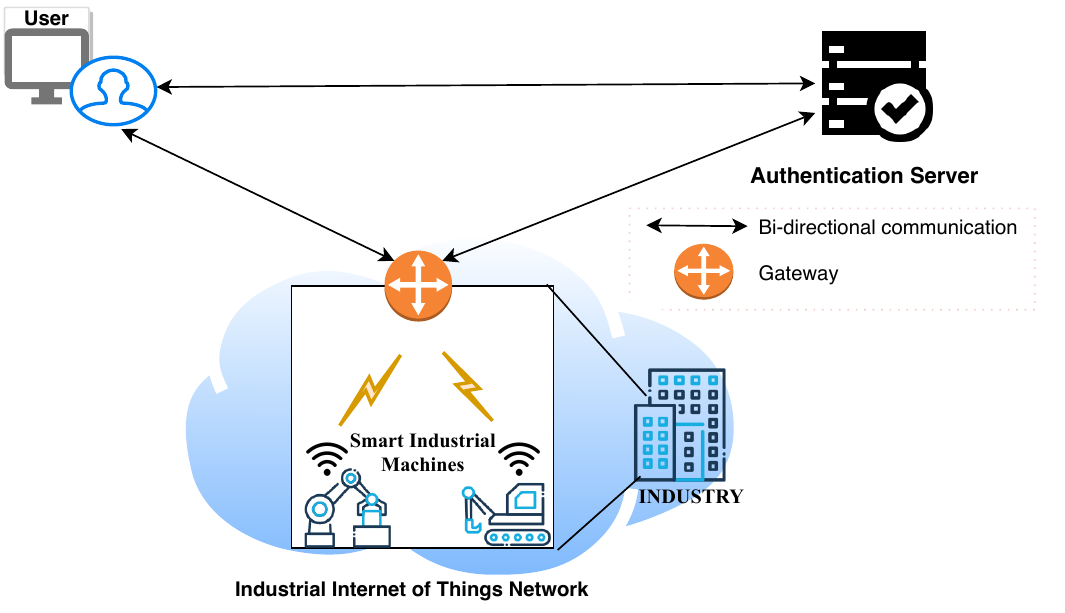
Figure 3. System